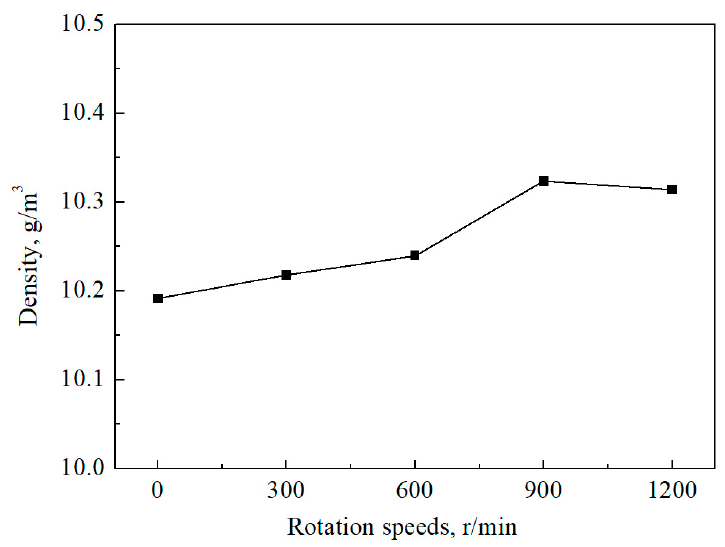
Figure 6. Density of the Ag–1.5Cu–1.0Y alloys obtained under different rotation speeds.